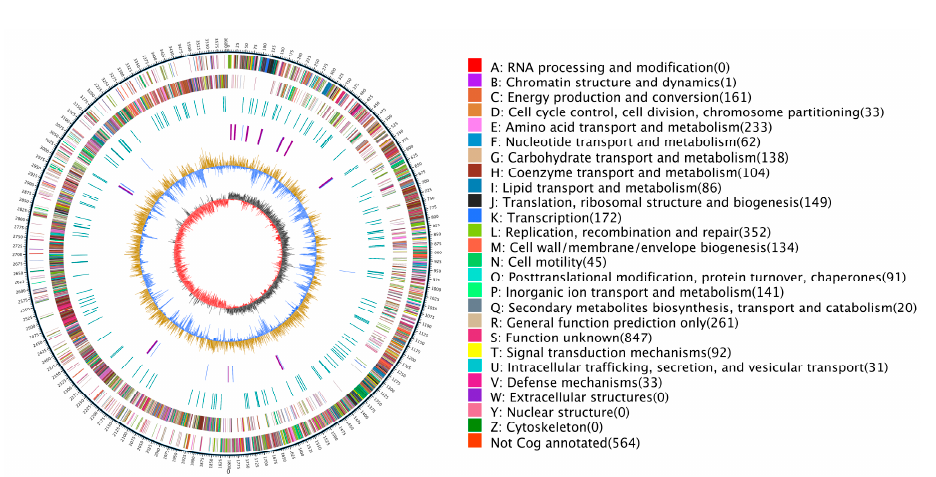
Figure 4. Circular genome map of G. stearothermophilus H6. Note: The outermost circle is a mark of genome size, each scale is 5 kb; the second and third circles are the gene on the positive and negative chains of the genome, respectively. Different colors represent different COG functional classifications; the fourth circle is the repeat sequence; the fifth circle is tRNA and rRNA, where blue is tRNA and purple is rRNA; the sixth circle is the GC content. The straw yellow part indicates that the GC content in this region is higher than the average GC content of the genome. The higher the peak value is, the greater the difference between the GC content and the average GC content is. The blue part indicates that the GC content in this region is lower than the average GC content of the genome; the innermost circle is GC skew. Dark grey represents the area where G content is greater than C, and red represents the area where C content is greater than G.